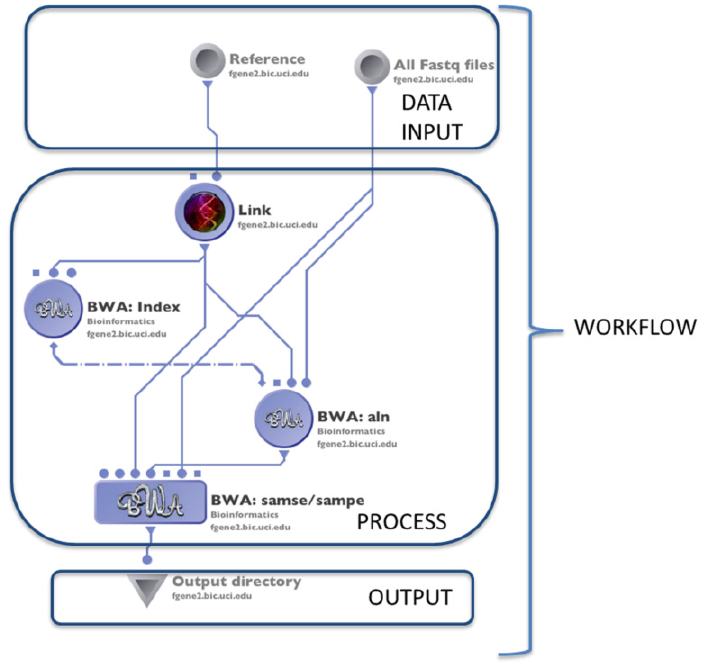
Figure 1. A snapshot of the general organization of a workflow within the LONI pipeline environment. This is an example of embedded modules into an alignment workflow based on BWA software. The user can simply set up the location of the input files in the data sources, manage the programs involved in the core modules, and indicate the location of the output files in the output data sink section. Every section can be interactively edited or modified through a menu of options accessed by right-clicking the mouse on the respective portion of the workflow.